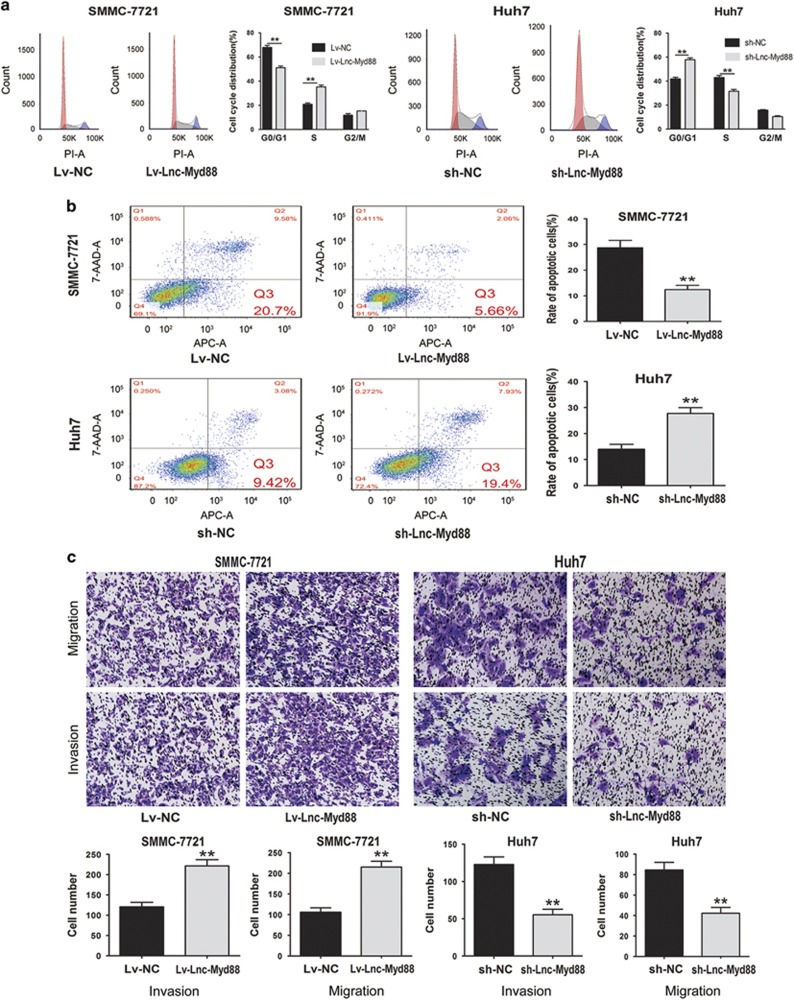
Lnc-Myd88 regulates hepatoma cells cell cycle, cell apoptosis and cell migration in vitro. (a) Cell-cycle analysis of SMMC-7721 cells stable overexpressing Lnc-Myd88 and Huh7 cells stable silenced Lnc-Myd88 expression was conducted by flow cytometry. The distribution of the cell cycle was shown in the graphs. (b) Cells were cultured with complete medium with 0.5 mM peroxide overnight, and cell apoptosis rate was detected by flow cytometry using the Annexin V-APC/7-AAD staining kit. The bar graph shows the percentage of apoptotic cells. (c) Invasion and migration assay of Lnc-Myd88 overexpressed and silenced cells. The bar graph shows the number of cells migrated or invaded through the membrane. Original magnification × 200. All experiments were performed in triplicate and presented as the mean±S.E.M. (*P<0.05, **P<0.01)